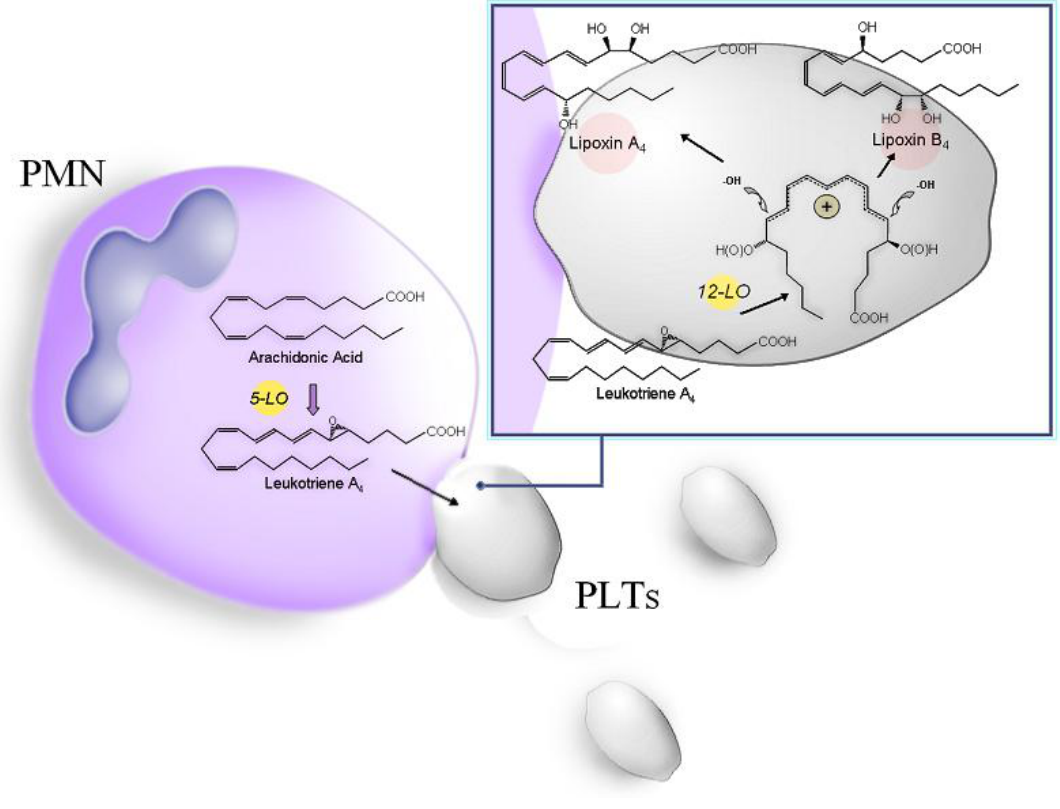
FIGURE 3. The 5-/12-LO pathway of lipoxin biosynthesis during interactions between PMNs and platelets.